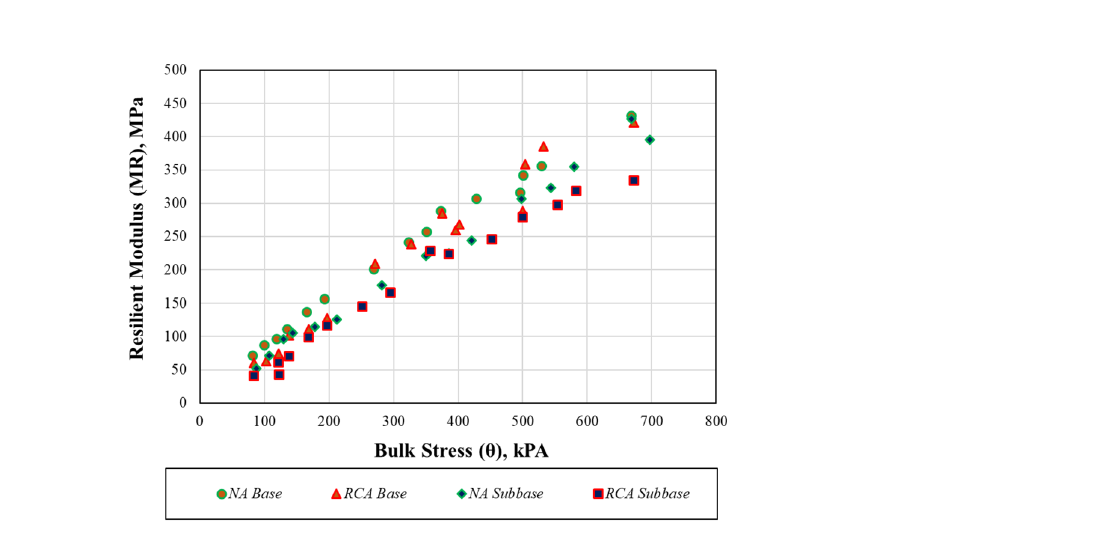
Figure 6. The changes in MR with bulk stress for each